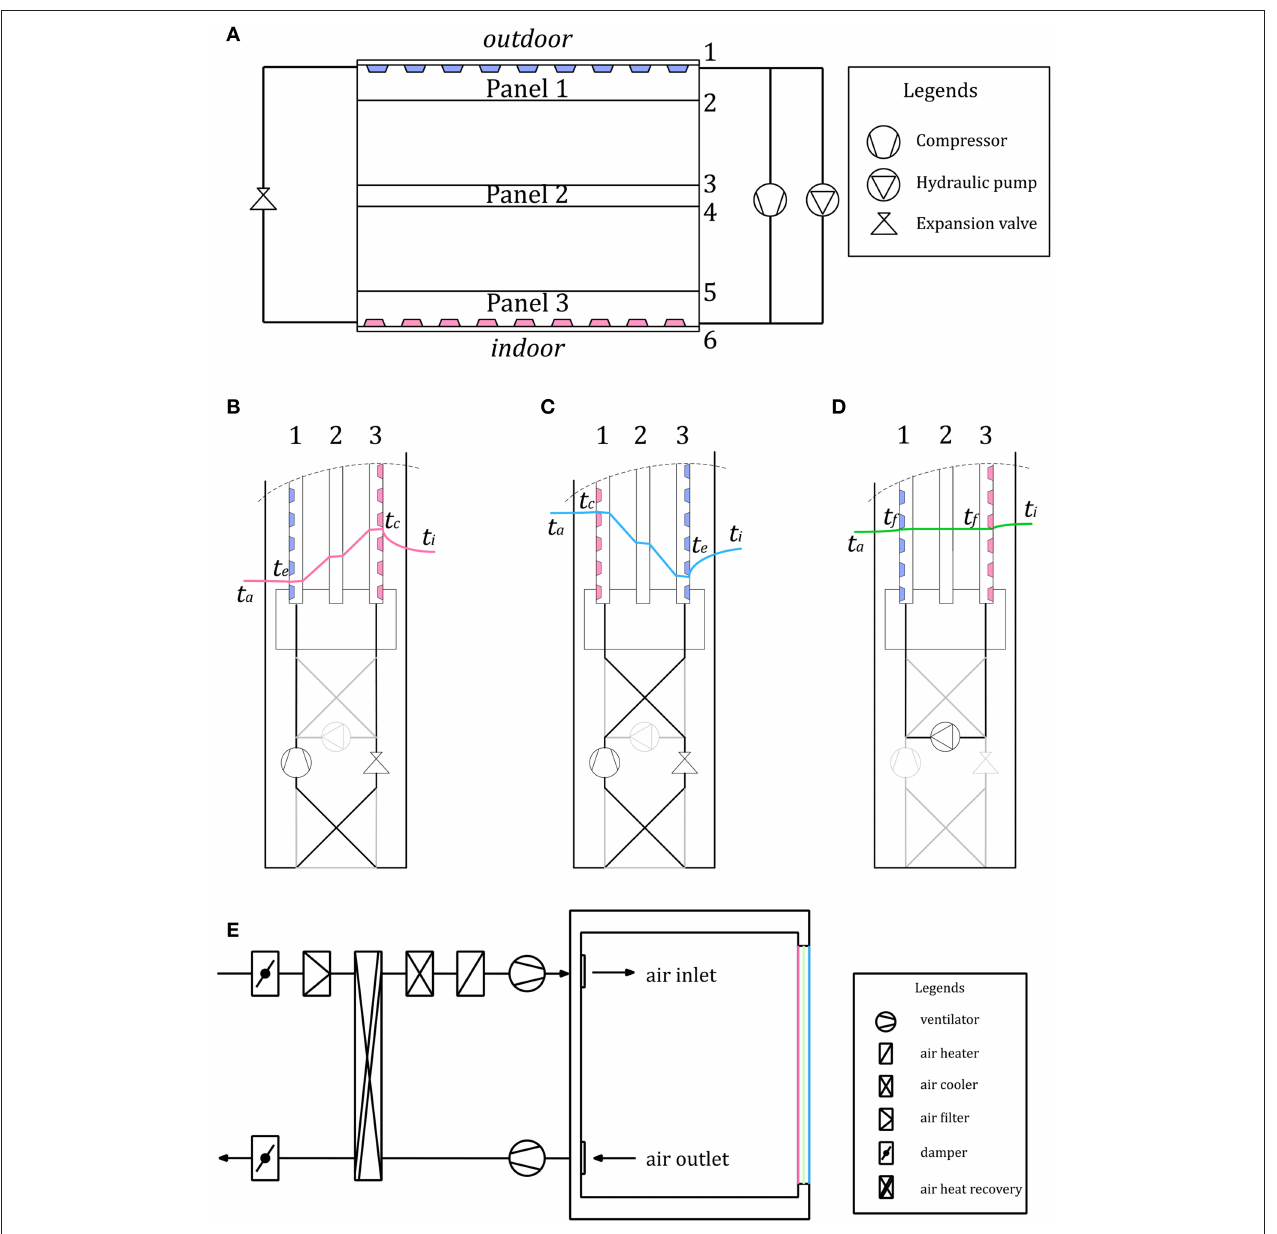
FIGURE 3 | (A) Design concept for a window-integrated condenser-evaporator. (B–D) Seasonal modes of operation and corresponding temperature profiles. t a , t i , t c , t e , and t f are the outdoor, indoor, condensing, evaporating and fluid temperature, respectively. (E) Interface of window-integrated condenser-evaporator with indoor ventilation